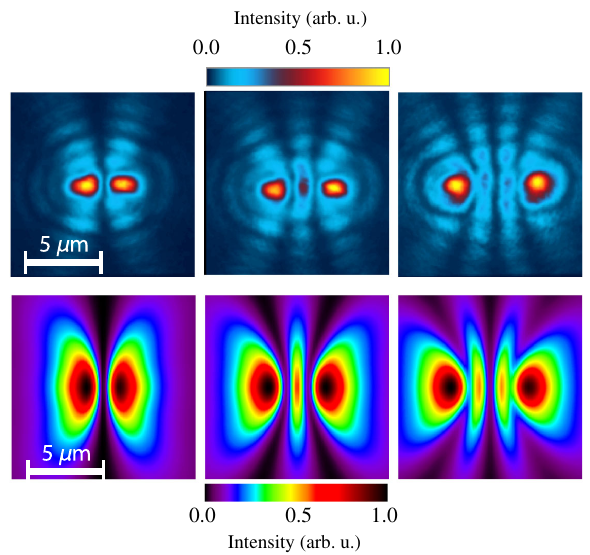
FIG. 1. (Upper row) The time-integrated images of two polar- iton condensates in real space at three different spatial separation distances. The condensates are formed simultaneously at P ≃ P , where P is the threshold power for condensation. th th The observation of an interference pattern between the two condensates indicates that they are phase correlated. Zero intensity of the interference pattern in the middle of the two sources indicates that the two condensates are antisynchronized. (Lower row) Time-integrated results of numerical simulations of the Ginzburg-Landau equations with random initial phase aver- aged over 75 realizations at separation distances between the condensates as in the experiment above. The condensates phase lock, on average, to zero or π phase difference depending on their spatial separation